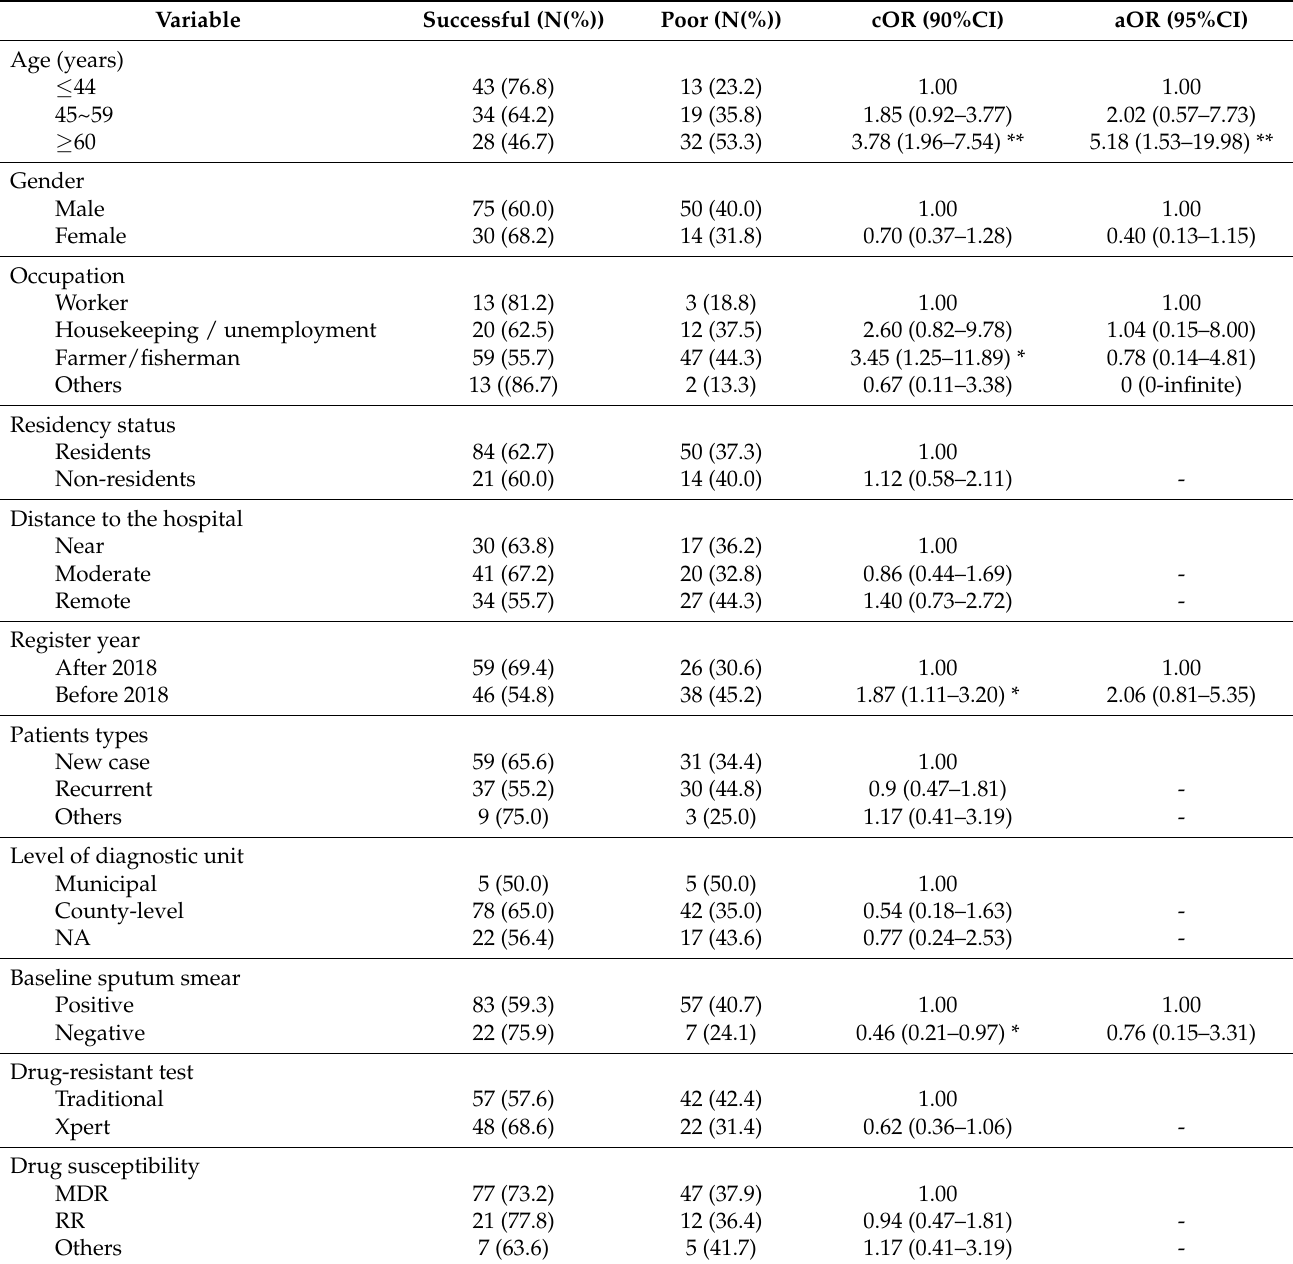
Table 5. Association of clinical and socio-demographic factors with treatment outcome among MDR/RR-TB patients (N =